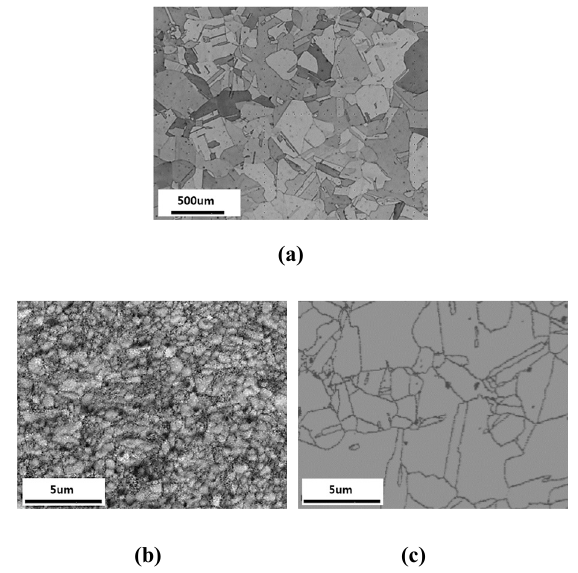
Fig. 4. Microstructure of (a) Forged OFHC copper, (b) ECAPed OFHC copper, (c) 200 copper after ECAP process.